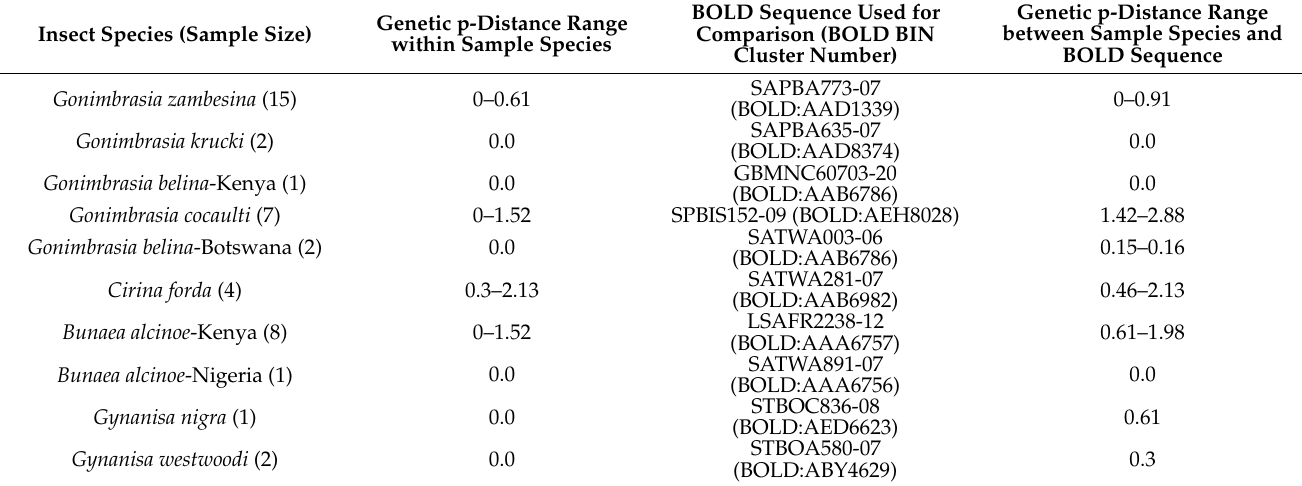
Table 3. Genetic p-distance comparisons for saturniid species.